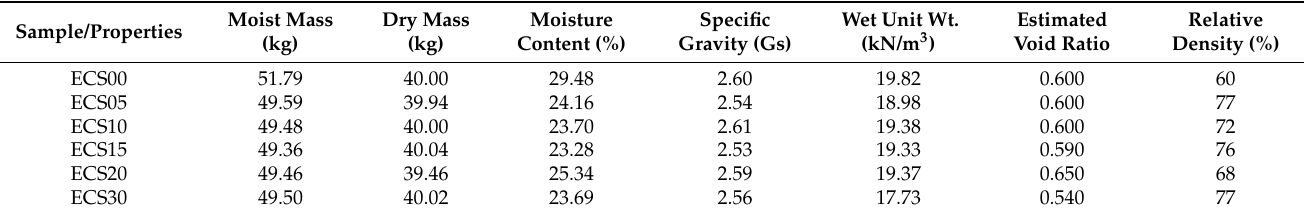
Table 2. Summary of experimental shaking table-physical model